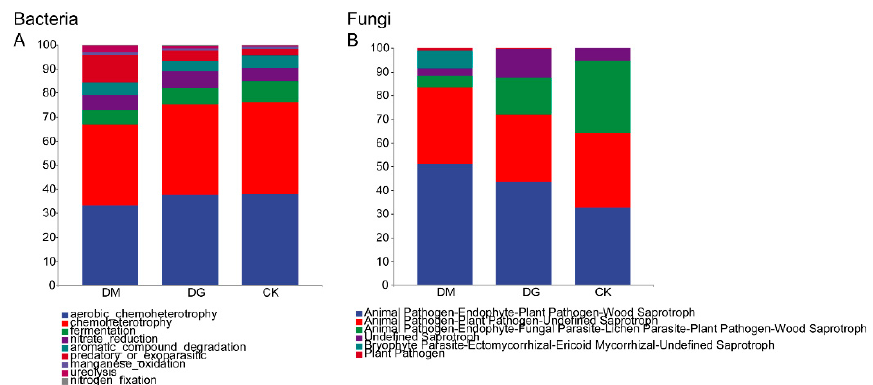
Figure 9. The top 10 bacterial genera in abundance as a function of ( A ) and the top 10 fungal genera in abundance as a function of ( B ).